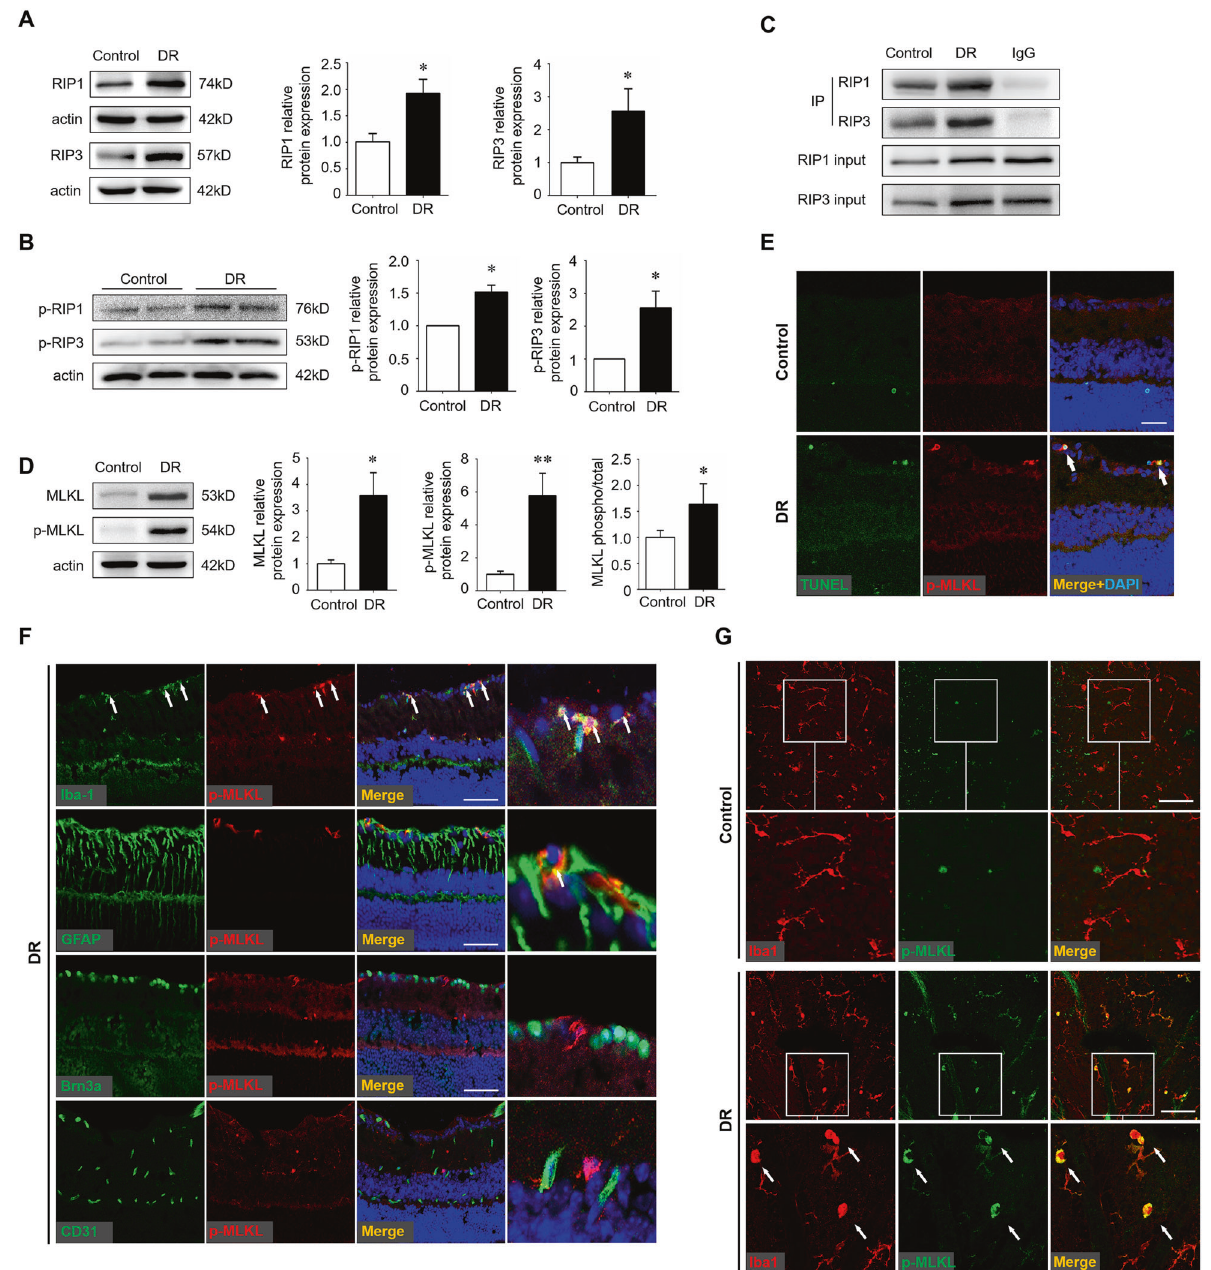
Fig. 2 Activation of microglial necroptosis in the diabetic retina. Streptozotocin-induced diabetes model was established and retina samples were collected 12 weeks after diabetes induction. Age-matched non-diabetes mice were used as control. A , B Protein levels of RIP1 and RIP3 ( A ), and phospho-RIP1 (p-RIP1) and p-RIP3 ( B ), were detected by western blotting. C Co-immunoprecipitation assays of RIP1 and RIP3 revealed that RIP1 coimmunoprecipitated with RIP3 in the diabetic retina. D Protein levels of MLKL and p-MLKL were detected by western blotting. E Combined p-MLKL staining and TUNEL assay on retinal cryosections. Arrows indicated necroptotic cells that were both p-MLKL and TUNEL positive. Scale bar: 50 μ m. F Double staining of p-MLKL with different cell markers on cryosections of the diabetic retinas. Iba1, a marker for microglia. GFAP, a marker for astrocytes and Müller cells. Brn3a, a marker for retinal ganglion cells. CD31, a marker for vascular endothelial cells. Arrows indicated cells co-stained with p-MLKL and iba1 and partially GFAP. Scale bar: 50 μ m. G Double staining of p-MLKL and iba1 on fl at-mounts of the diabetic retina and non-diabetic control. Arrows indicated cells co-stained with p-MLKL and iba1. Scale bar: 50 μ m. Western blotting assays were repeated 3 times. Data were shown as mean ± S.D. * P < 0.05. ** P < 0.01. than non-diabetic ones. GSK-872 treatment greatly improved the pupillary light re fl ex by enhancing the contraction ampli- tude while decreasing contraction time (Fig. 5C). Collectively, We also evaluated the pupillary light re fl ex by measuring the these data demonstrated that blockade of microglial necropto- pupil constriction in the diabetic mice with and without sis with GSK-872 improved the light sensitivity and visual treatment. As a result, diabetic mice presented a larger pupil function of diabetic mice. area with light stimulation and longer pupil contraction time Cell Death and Disease (2023)